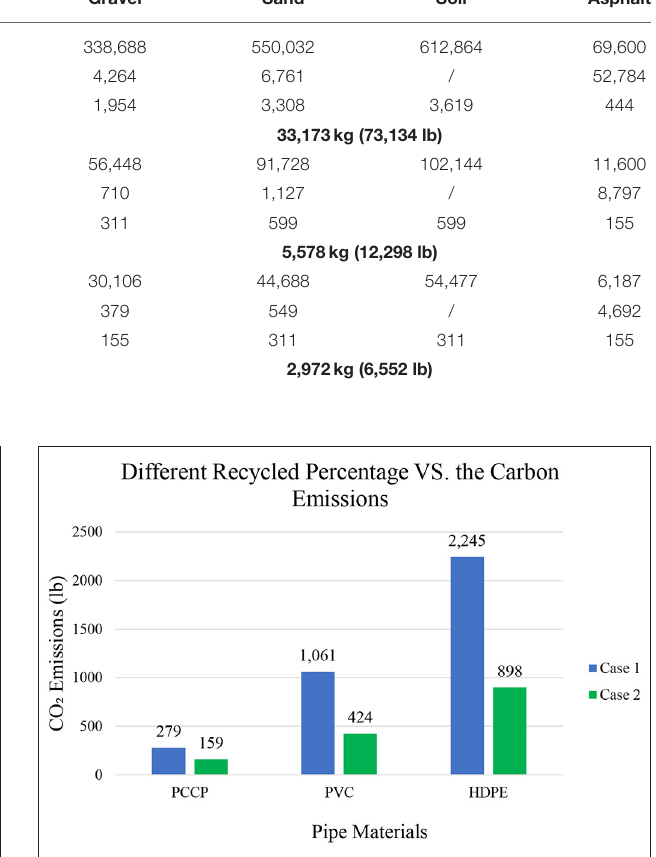
FIGURE 5 | Comparing the carbon emissions between new backfill materials/asphalt pavement and same backfill materials/ concrete pavement during the installation phase.